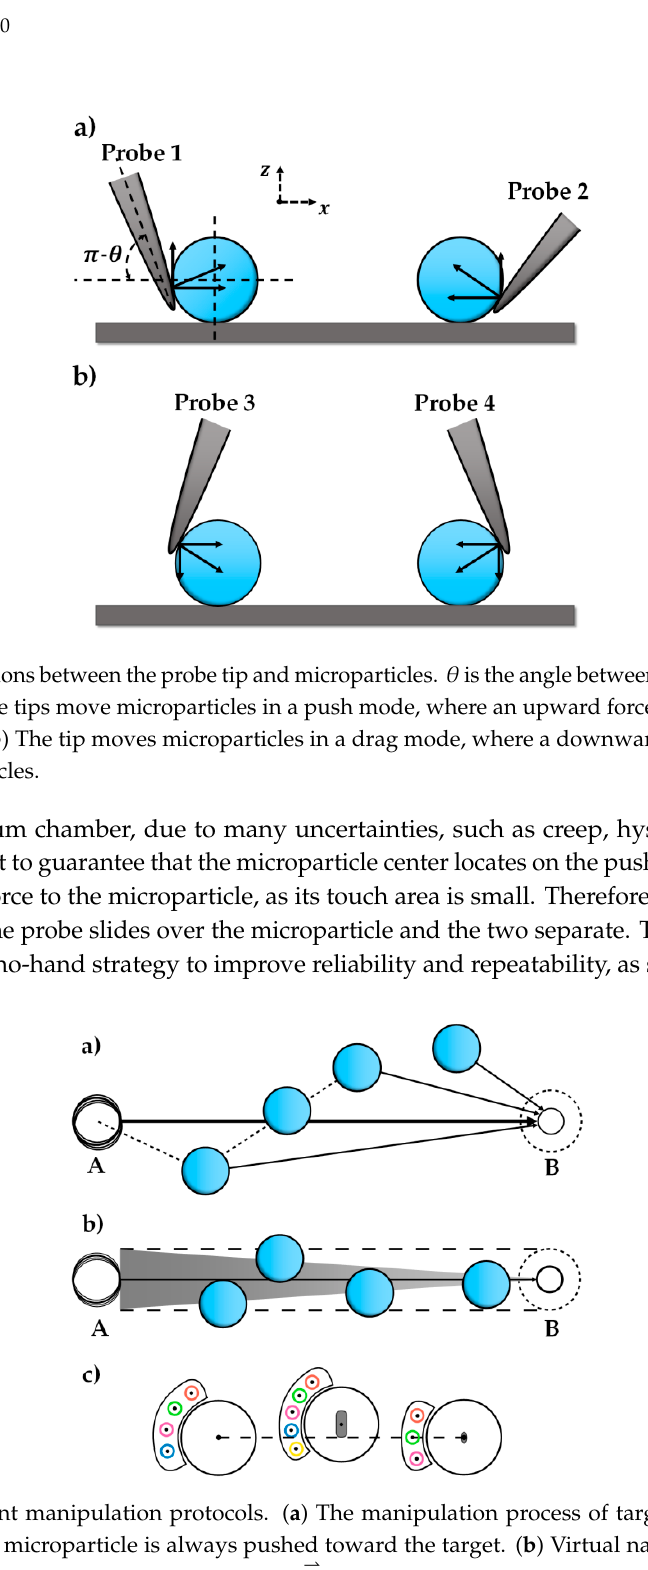
Figure 2. Different manipulation protocols. ( a ) The manipulation process of target-oriented push (TOP), where the microparticle is always pushed toward the target. ( b ) Virtual nano-hand strategy, where the push direction is always parallel to (cid:1827)(cid:1828)(cid:4652)(cid:4652)(cid:4652)(cid:4652)(cid:4652)(cid:3377) . ( c ) Stable pushing of the microparticle with the nano-hand